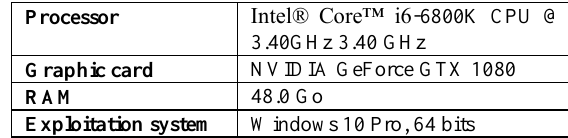
Table 3. Technical characteristics of the computer used with the Oculus headset.